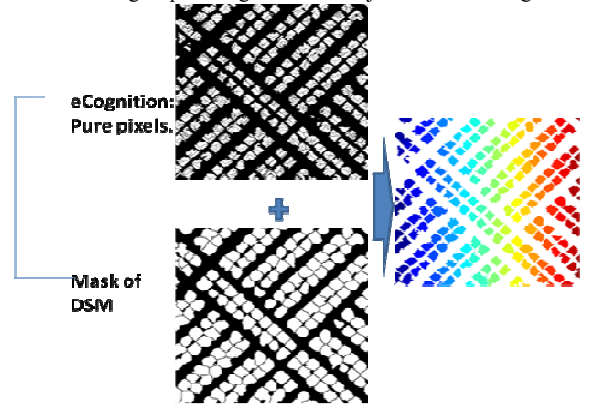
Figure 2 Flow chart graphic